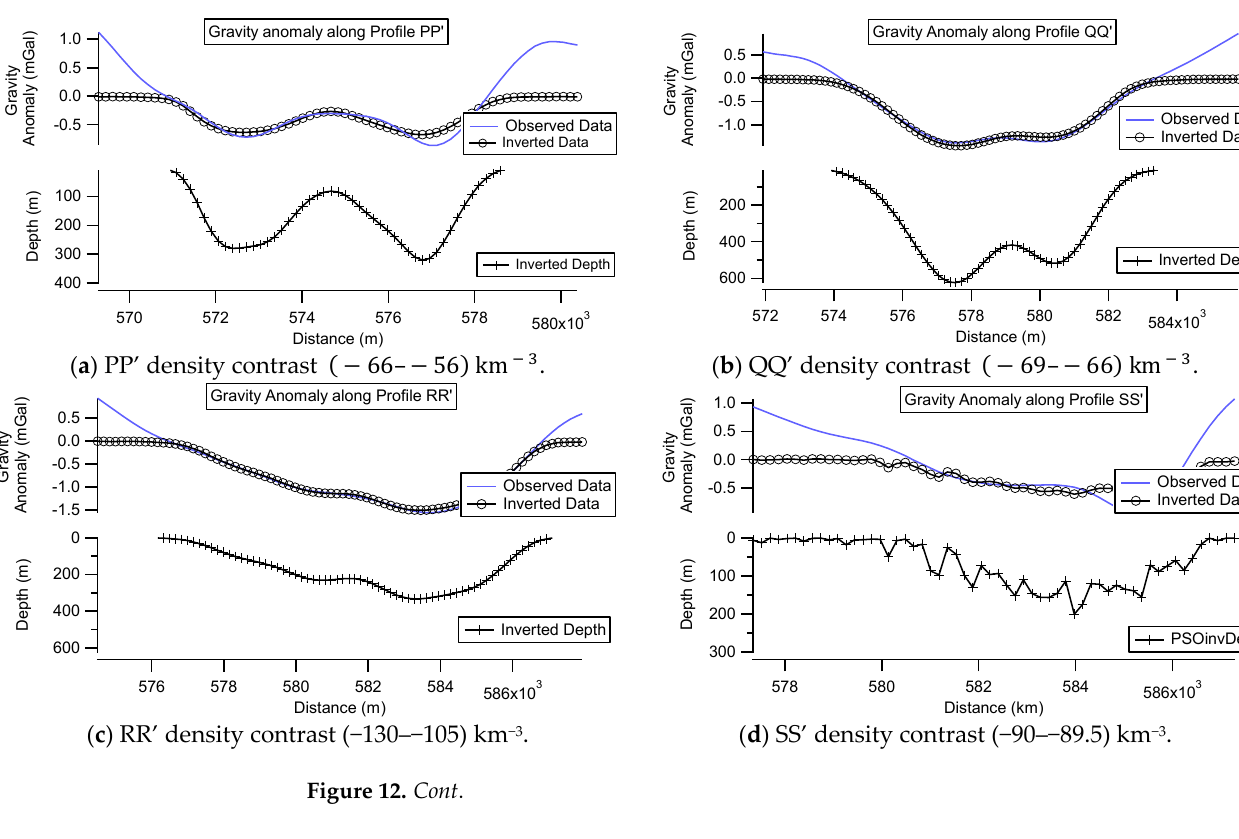
( c ) RR’ density contrast ( − 130– − 105) km − 3 . ( d ) SS’ density contrast ( − 90– − 89.5) km − 3 .